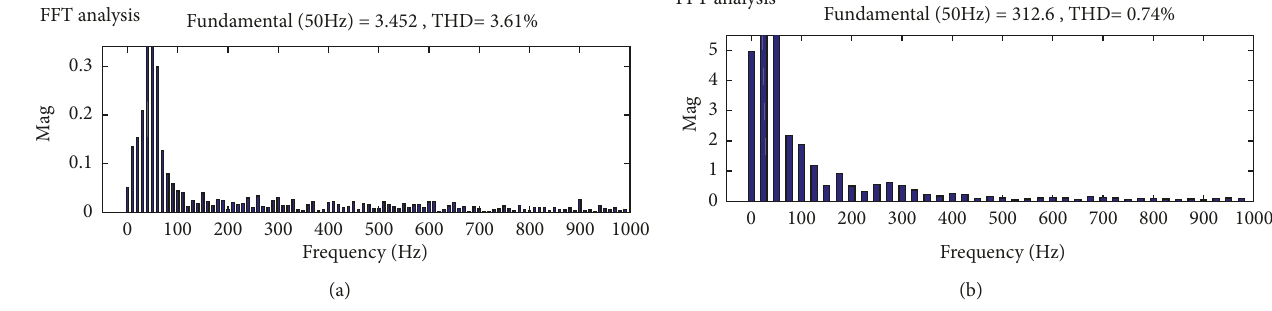
Figure 14: (a) Grid current harmonic spectra. (b) Voltage harmonic spectra.